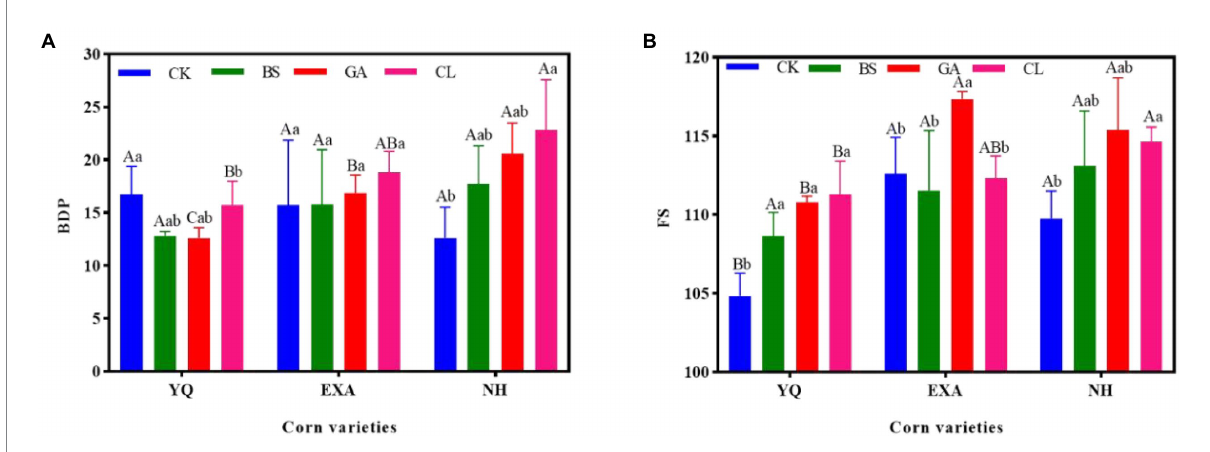
FIGURE 1 Effects of Varieties and Additives on (A) BDP and (B) FS of Whole-plant corn silage. BDP, biological degradation potential; FS, flieg score; YQ, corn variety Yuqing 386; EXA, corn variety Enxiai 298; NH, corn variety Nonghe35; CK, no additives; BS, 0.02% Bacillus subtilis CP7 of FM; GA, 0.2% gallic acid of FM; CL, 0.02% cellulase of FM; capital letters indicate significant differences between varieties under the same treatment ( p < 0.05). Lowercase letters indicate significant differences among different treatments of the same variety ( p <